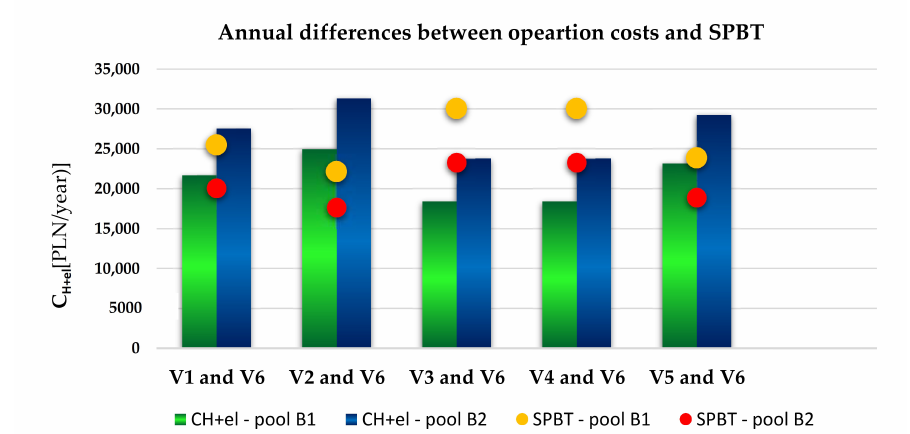
Figure 8. The di ff erences between the operating costs of the individual variants in relation to the cheapest variant (V6) and the SPBT index—sports pool B1 and recreation pool B2.